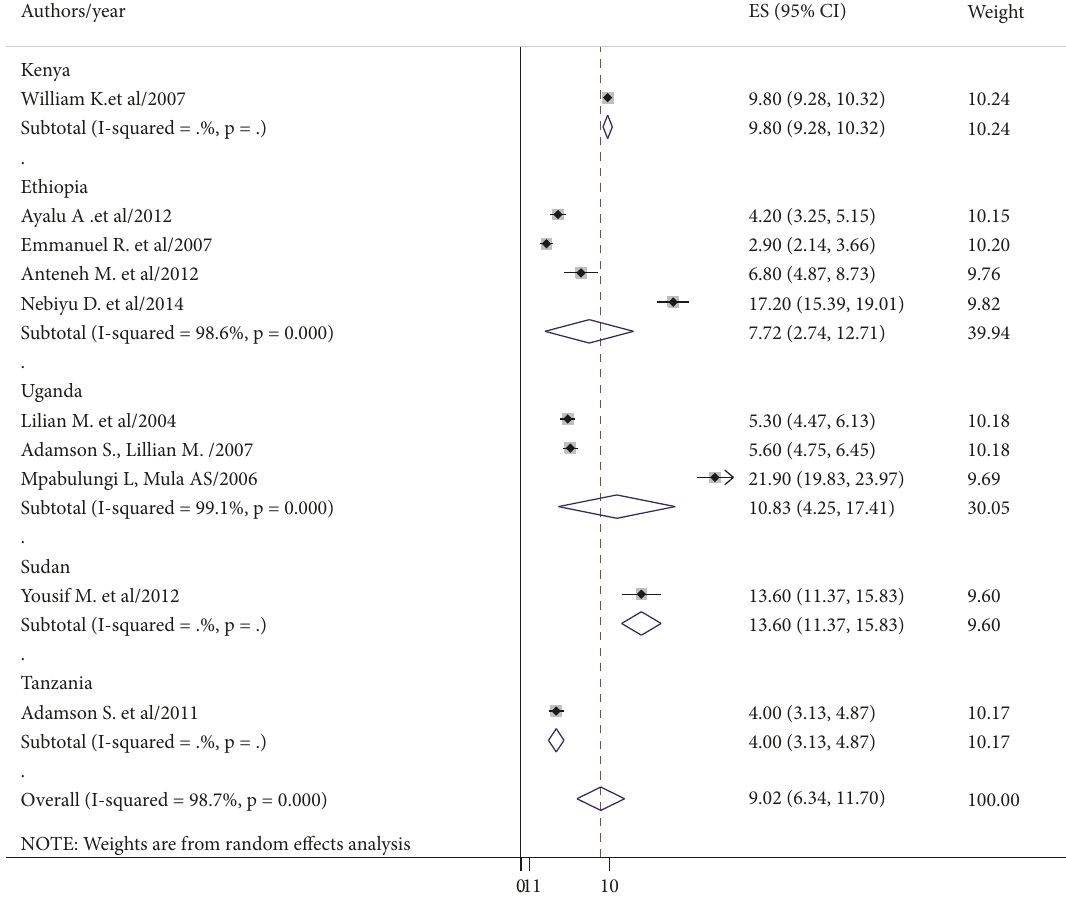
Figure 3: The forest plot showed the subgroup analysis of the prevalence (ES) of cigarette smoking among school-going adolescents. The midpoint and the length of each segment indicated prevalence and a 95% CI, whereas the diamond shape showed the combined prevalence of all